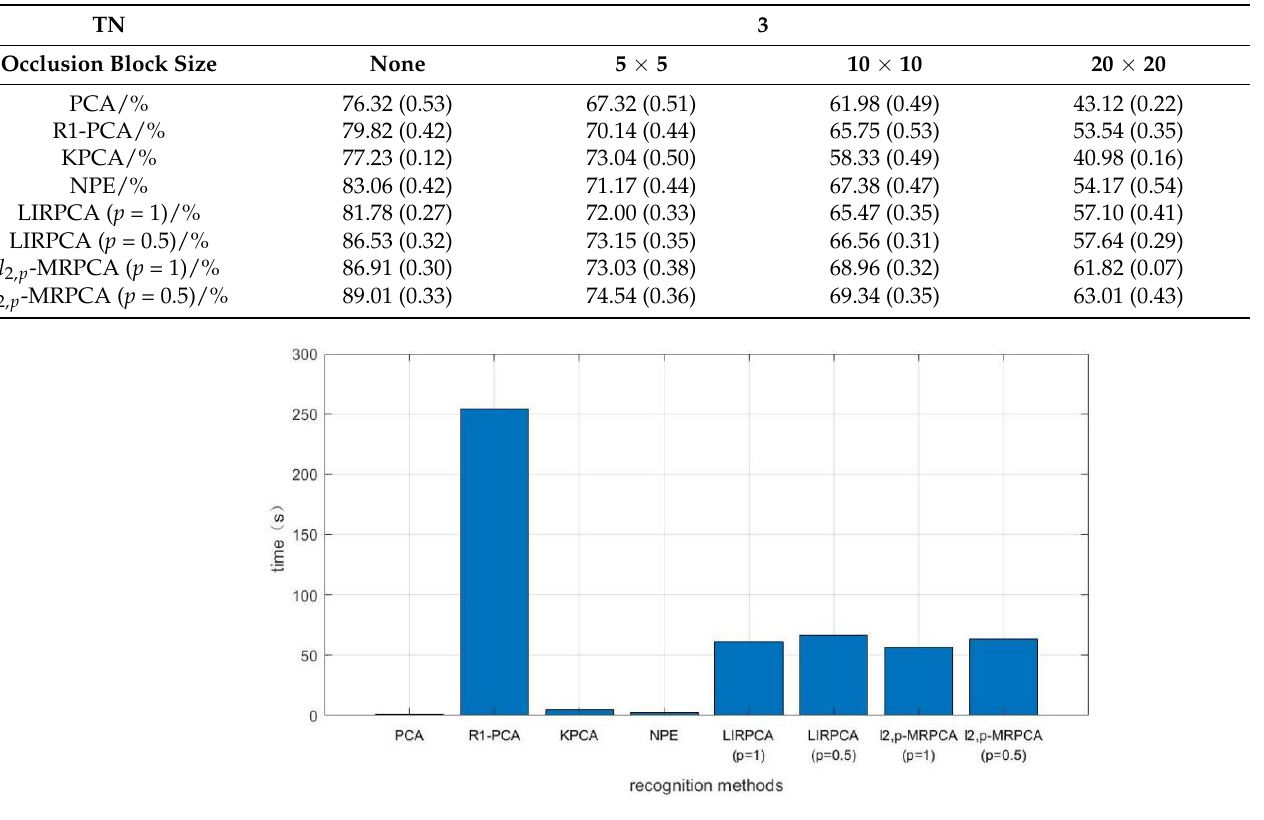
Figure 6. Training time on the PolyU palmprint database .